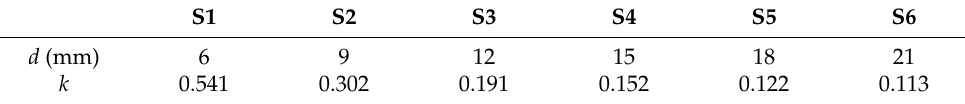
Table 7. Measured equivalent elastic coefficient under different pore diameters ( d